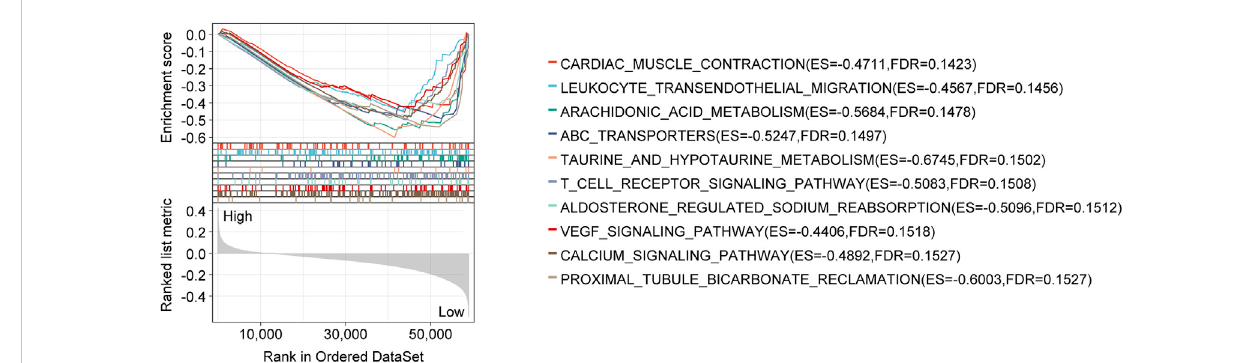
FIGURE 6 GSEA analysis with the KEGG gene set as the background identi fi ed relevant pathways of the CRLncSig. The signi fi cance threshold of this analysis wassetas: p-value < 0.05,and FDR < 0.25.GSEA:GeneSetEnrichmentAnalysis;KEGG:KyotoEncyclopediaofGenesandGenomes;FDR:falsediscovery